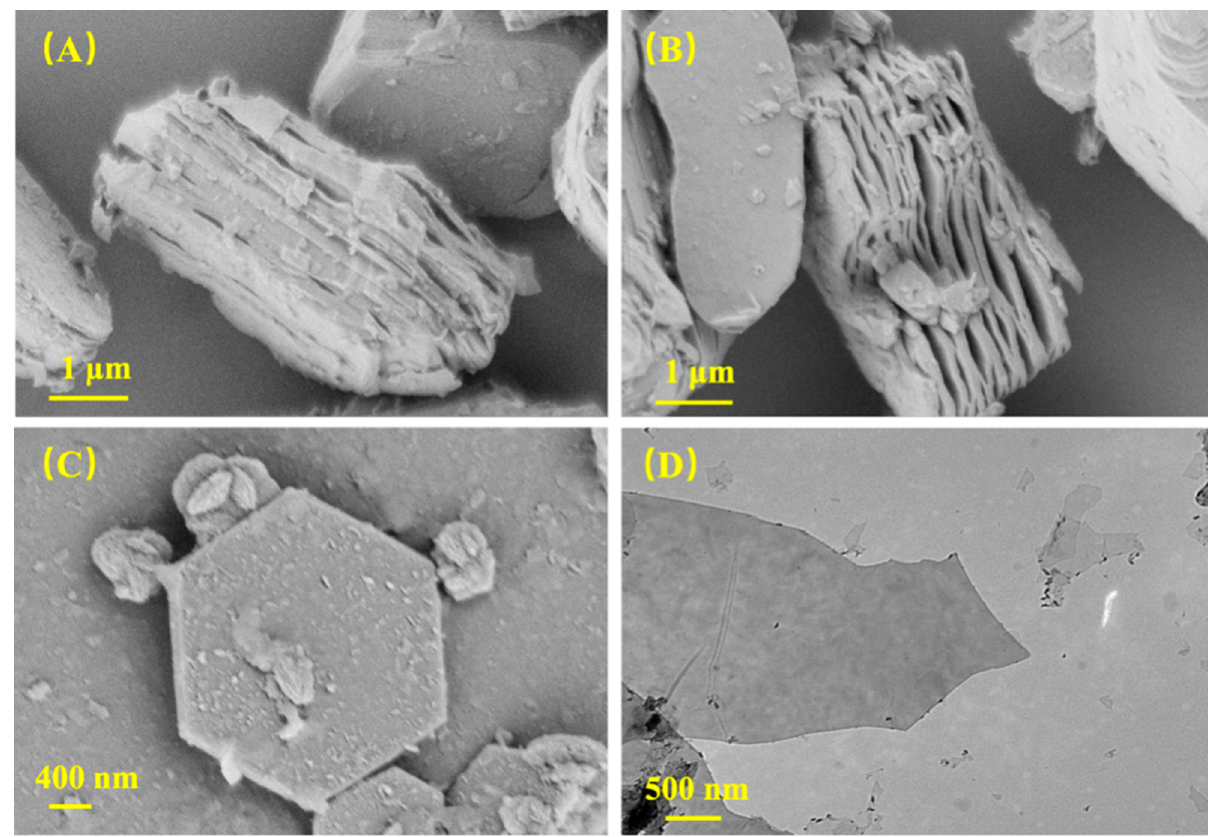
Figure 1. Images of MXene and MXene/PVA nanocomposites: SEM images of etched MXene ( A , B ); and delaminated MXene ( C ); TEM image of delaminated MXene ( D ).